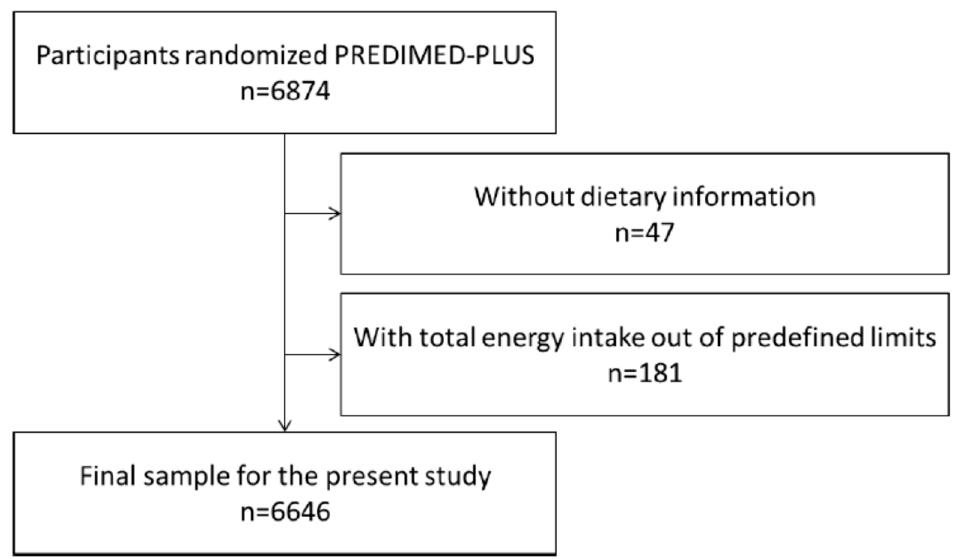
Figure 2. Flow-chart of participants.